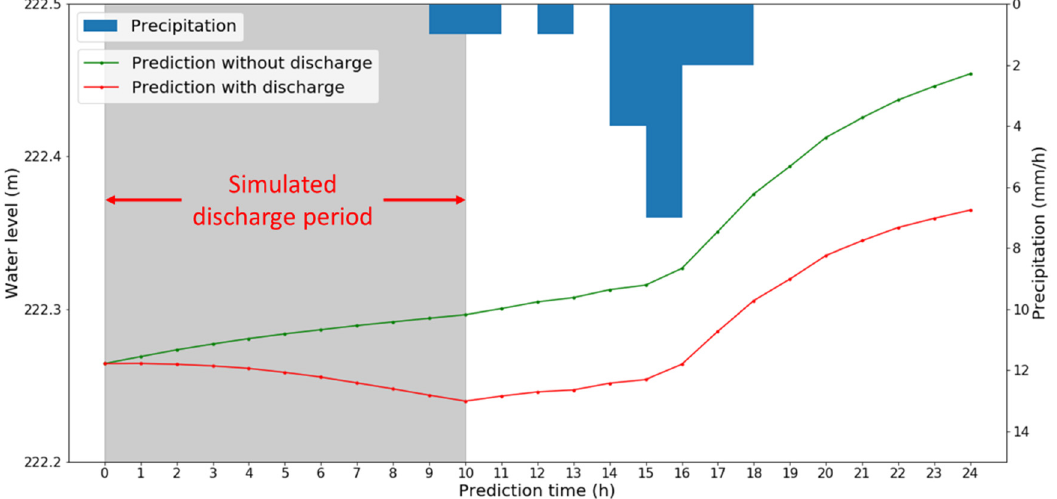
Figure 7. Example application of the developed model for predicting water-level changes when water was released before a forecasted rainfall event.